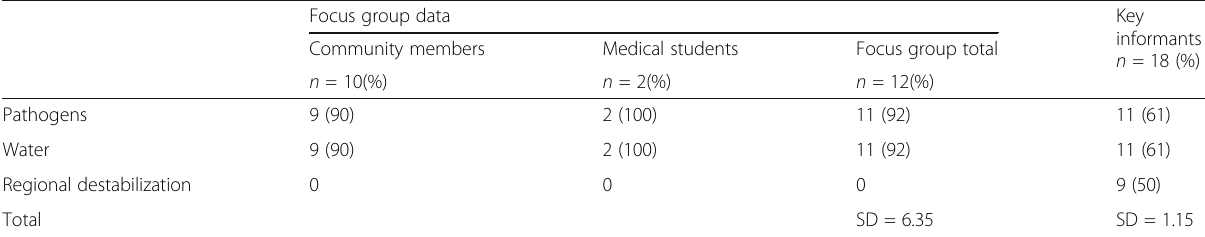
Table 1 Major concerns discussed across sample population Focus group